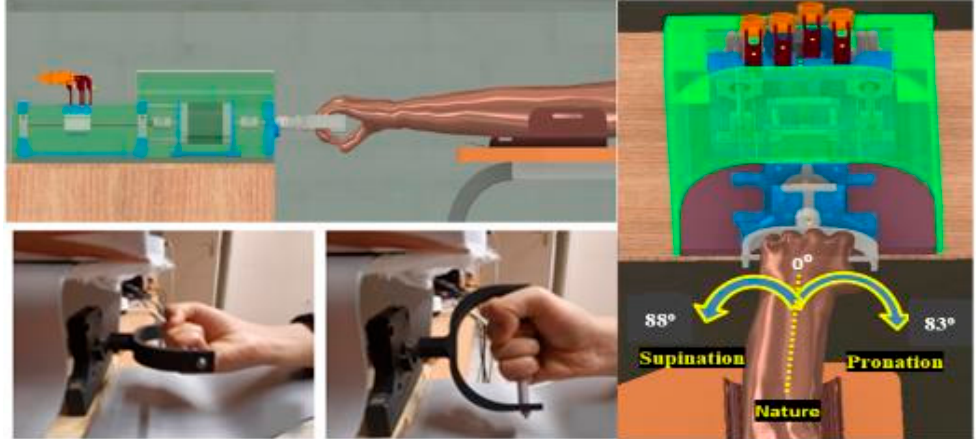
Figure 6. 3D model structure and health object integration with the proposed hand forearm supination/pronation (S/P) attachment mechanism.